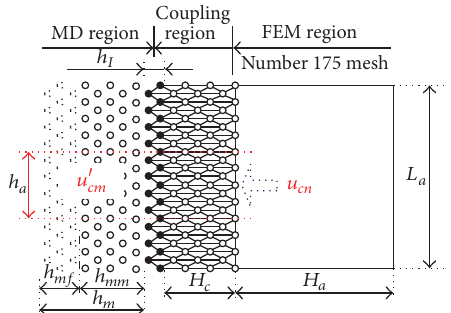
Figure 8: The design for ET region of FEM/MD and the process of energy transfer.